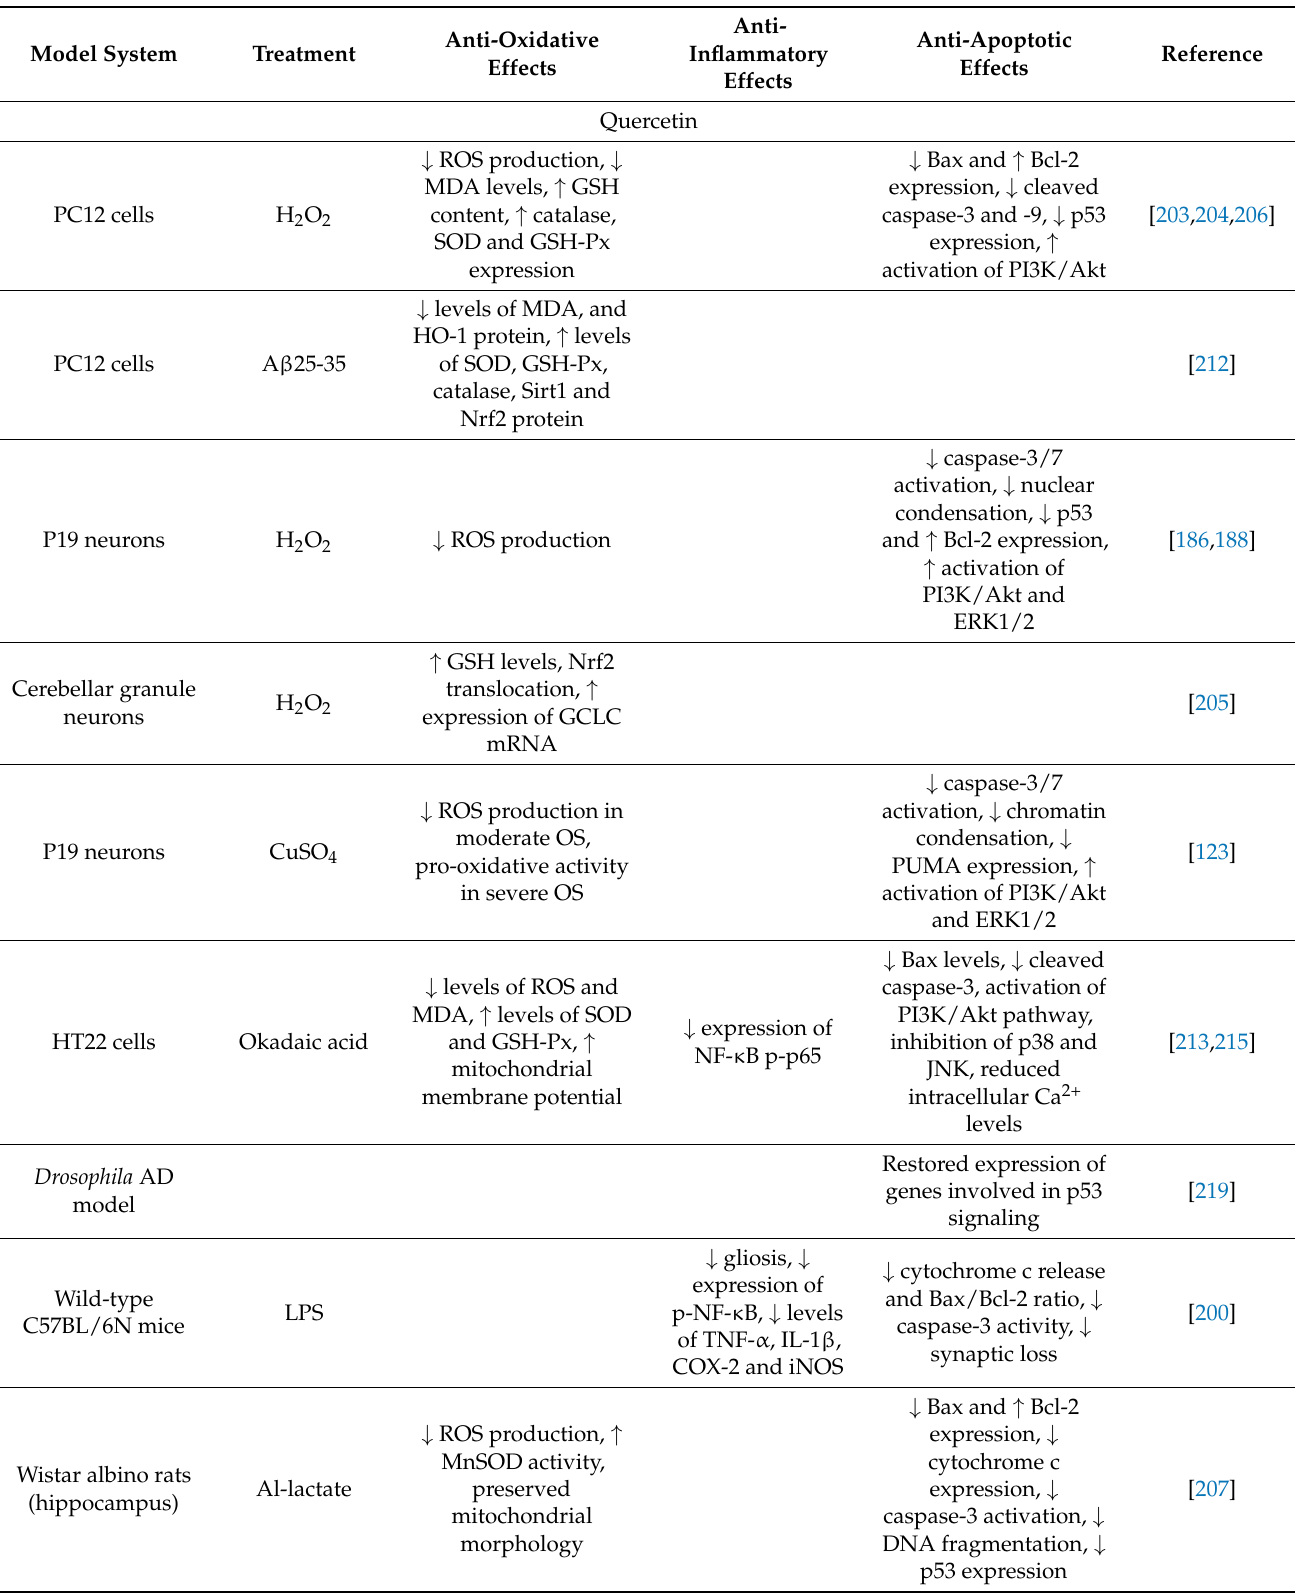
Table 1. Anti-oxidative, anti-inflammatory and anti-apoptotic effects of flavonols in various experimental conditions related to neurodegenerative